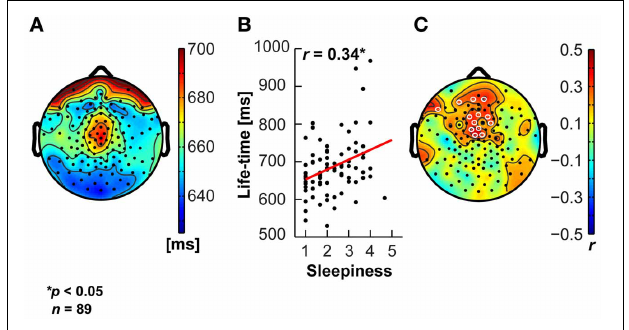
FIGURE 7 | Sleepiness correlates positively with sustained theta activity. The theta oscillation life-time biomarker shows a central topography (A) , and correlates positively (significant electrodes in white open circles) with the Sleepiness score of the ARSQ in medial fronto-central scalp regions (B,C)